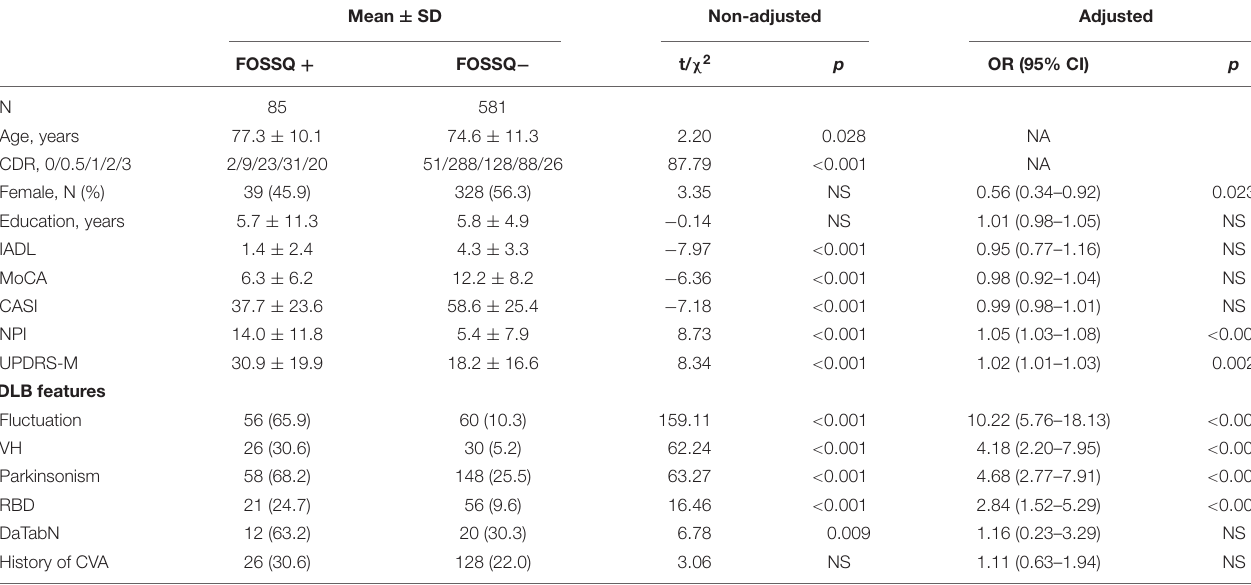
TABLE 2 | Comparison of demographic and background characteristics between groups with FOSSQ + and FOSSQ – adjusted for age and disease severity according to